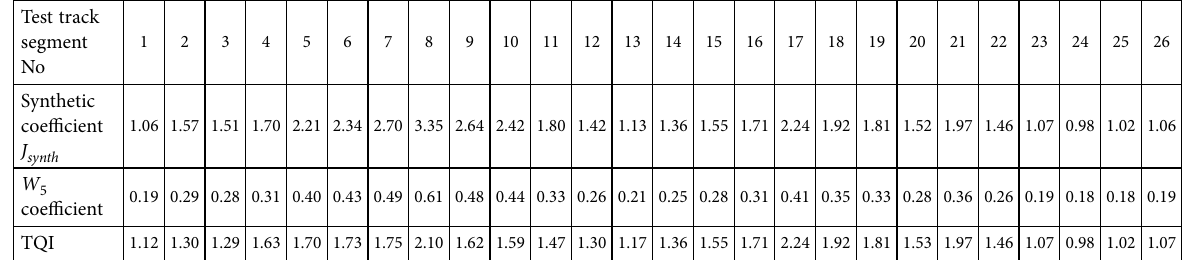
Table 3. Average values of TQIs for 300 m long segments of the test track computed in 3 ways